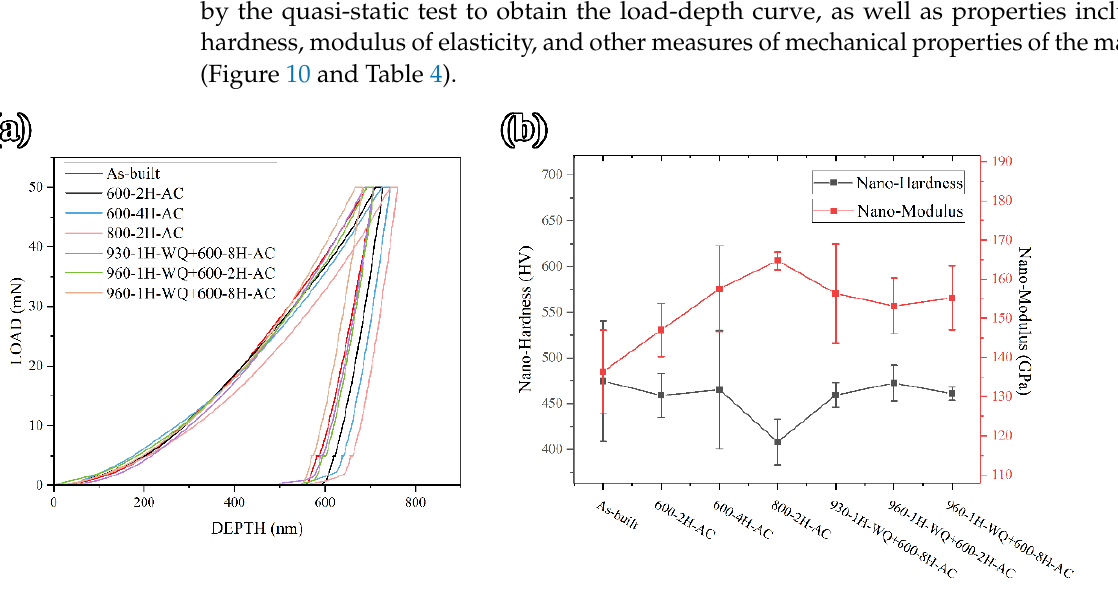
Figure 10. ( a ) LOAD-DEPTH curve of SLM TC4; ( b ) Nano-Hardness and Nano-Modulus of SLM TC4 (x-z). Table 4. Nanoindentation hardness and modulus of elasticity of SLM TC4 under different heat treatments.